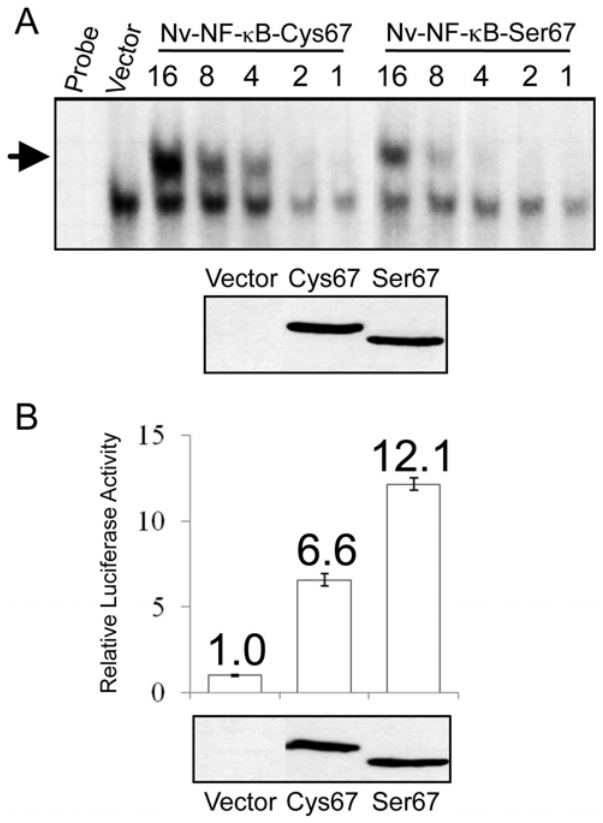
Figure 6. Comparison of the DNA-binding and transactivation properties of the proteins encoded by the two Nv-NF- k B alleles. (A) An EMSA was performed using a radioactive k B-site probe and A293 cell extracts containing approximately equal amounts of each indicated FLAG-Nv-NF- k B protein (top panel). Two-fold dilutions of the equalized extracts spanning a 16-fold concentration range were used in the EMSA. The position of the NF- k B-DNA complex is indicated by the arrow. Anti-FLAG Western blotting (bottom panel) was performed to verify that the amounts of the two proteins were roughly equal. Probe, probe alone; Vector, an extract from pcDNA empty vector-transfected cells containing an amount of protein equal to the ‘‘16’’ lane of Nv-NF- k B-S67. (B) A reporter gene assay using a multimerized k B-site luciferase reporter gene was performed in A293 cells as described in Materials and Methods. Cells were co-transfected with expression plasmids either containing no insert (Vector) or the indicated Nv-NF- k B proteins. Values are relative to the normalized luciferase activity seen with the Vector (1.0). Values are the averages of three experiments, each performed with triplicate samples. An anti-FLAG Western blot of normalized extracts used in the reporter gene assay, to confirm approximately equal expression of the two Nv-NF- k B proteins (bottom panel).